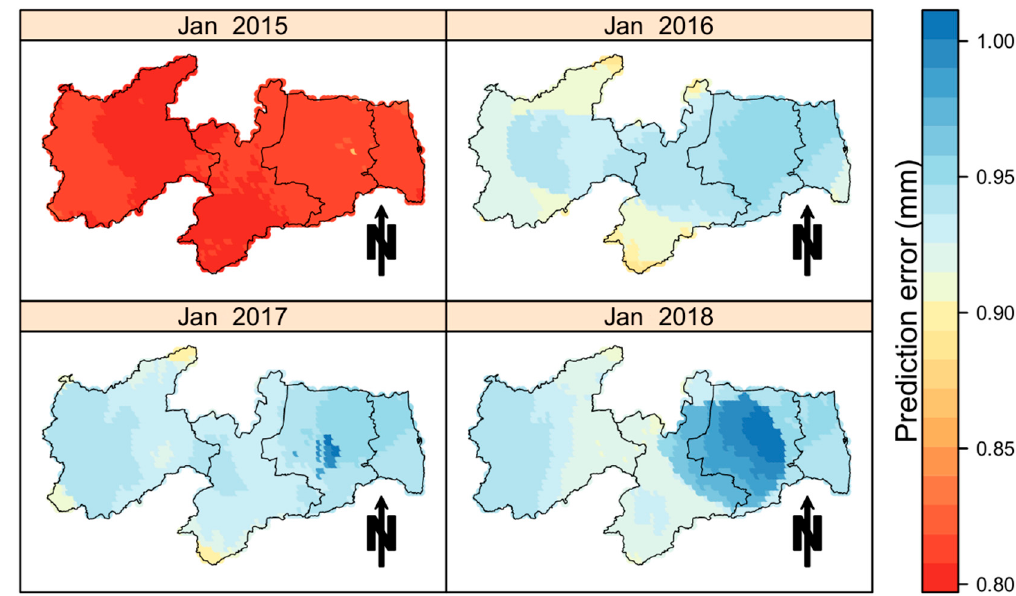
Figure 9. Maps of the standard error of precipitation prediction in January 2015–2018.